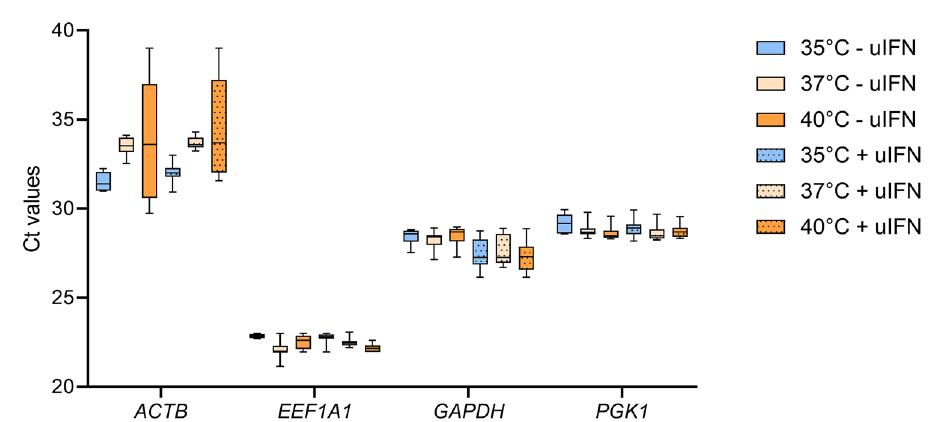
Figure 2. Expression stability of candidate reference genes under different conditions. Bat primary fibroblasts were incubated at 35 °C, 37 °C or 40 °C in the presence or absence of 1,000 U/ml universal type I interferon (uIFN). Gene expression levels of ACTB , EEF1A1 , GAPDH and PGK1 were determined by qRT-PCR. Data show mean ± SD from 3 independent